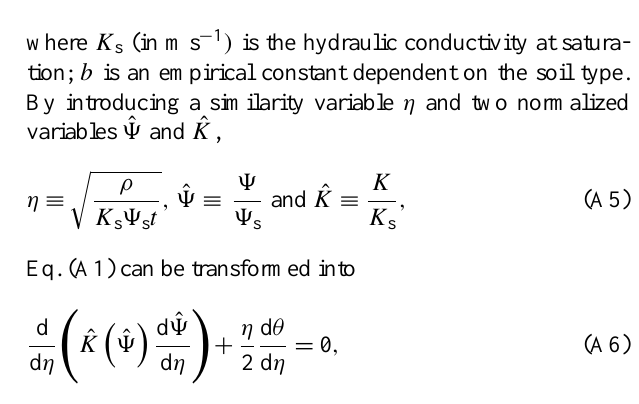
Figure A1. Schematics of the root flow–soil boundary and soil moisture transition for the parameterization of horizontal water flux q x . The red dashed line represents the analytical solution, and the black-solid line represents the parameterization. Soil moisture is saturated (i.e., θ s ) in the root–soil boundary (width λ ), and decreases linearly in the transition zone (width δ ) before reaching that of the bulk soil ( θ w )